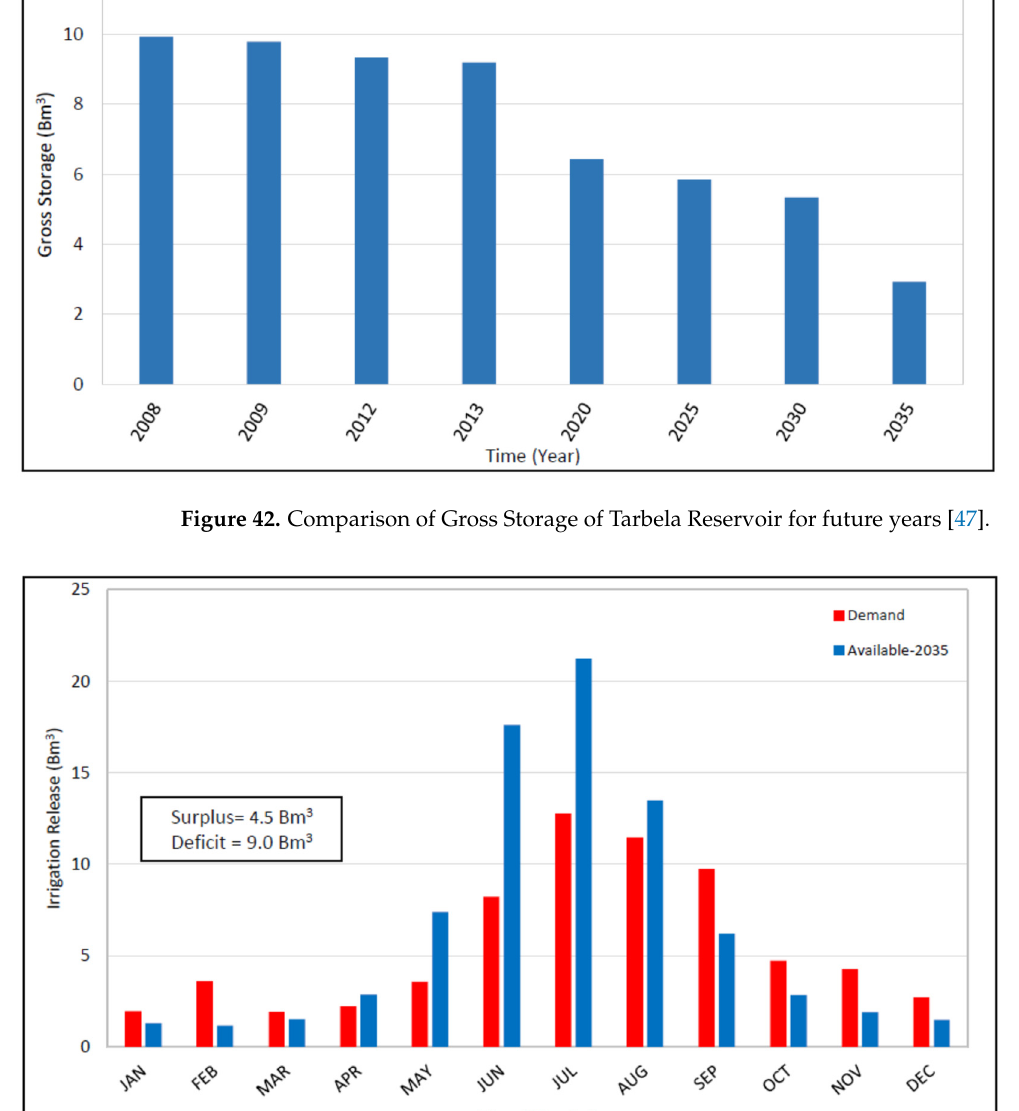
Figure 43. Comparison of Expected Irrigation Releases and Demand in 2035.